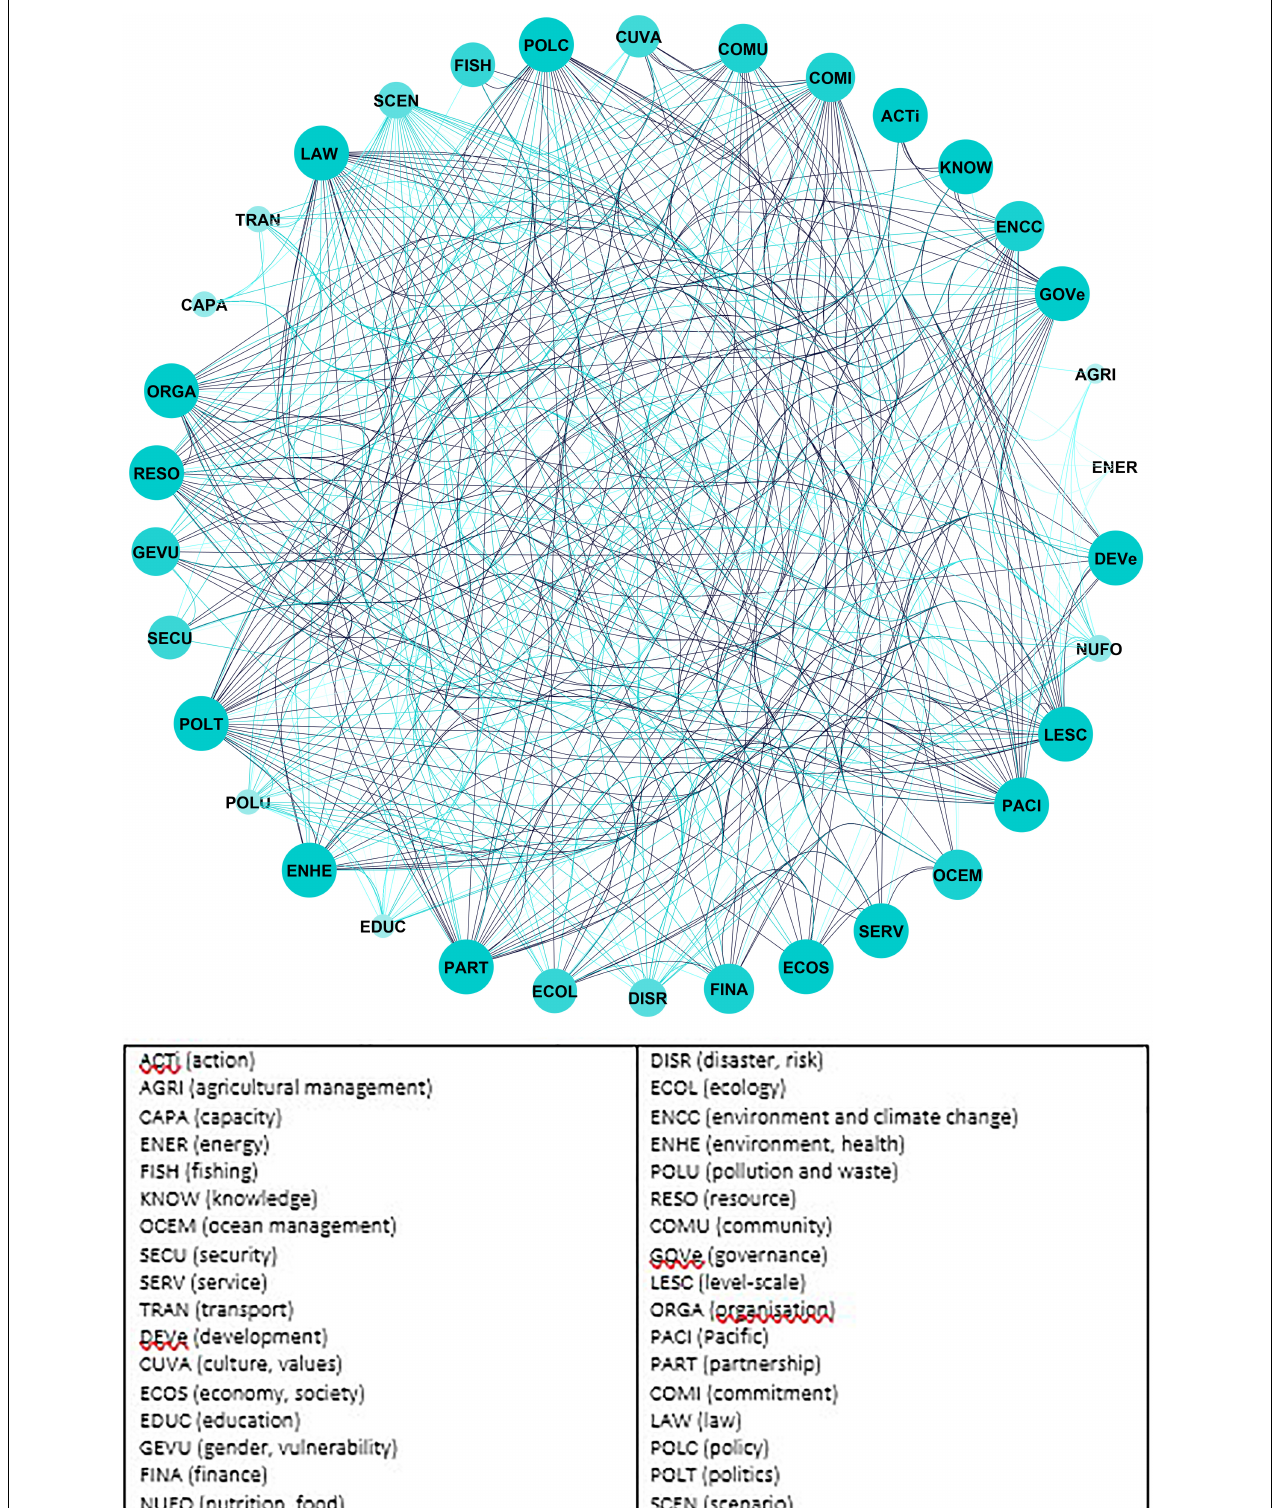
FIGURE 8 | Network of the 34 themes. Each node represents a theme indicated by its label. Two themes are linked if they are both addressed by the same N policies (N values not shown). The ball size is related to its level of linkage (defined as the sum of the weights of its links); with higher weights being represented as darker shading. Theme summary description in table below, for further detail and description of lemmas in each theme see Supplementary Material .